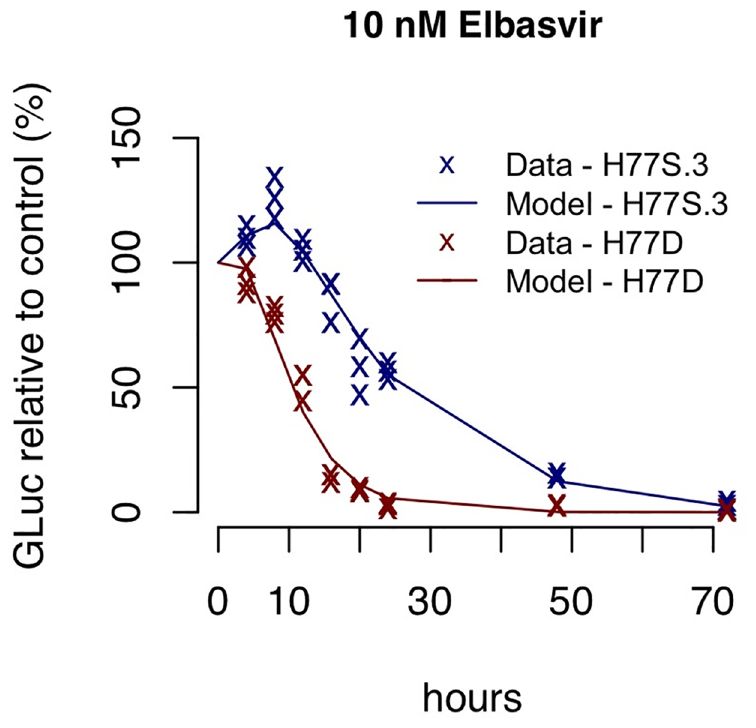
Fig 4. Results of the mathematical model fitted to data measuring the decline of GLuc-reporter activity from the H77S.3 or H77D variants under 10nM elbasvir treatment. Data and simulationusing best fit parameter values are shownas ‘x’s and lines, respectively. The data and simulationshown here represent the 10nM elbasvirtreatment from S5 and S8 Figs. Here, they are overlaidon the same graph to highlightthe transient increase in GLuc activity observedat 4-8h followingNS5A inhibitoradditionto cell cultures infected with H77S.3/GLuc2A but not H77D/GLuc2A.